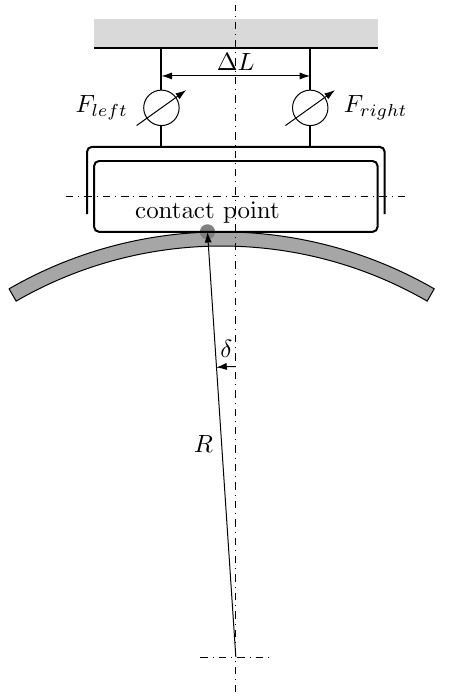
and mean angle µ δ are tot